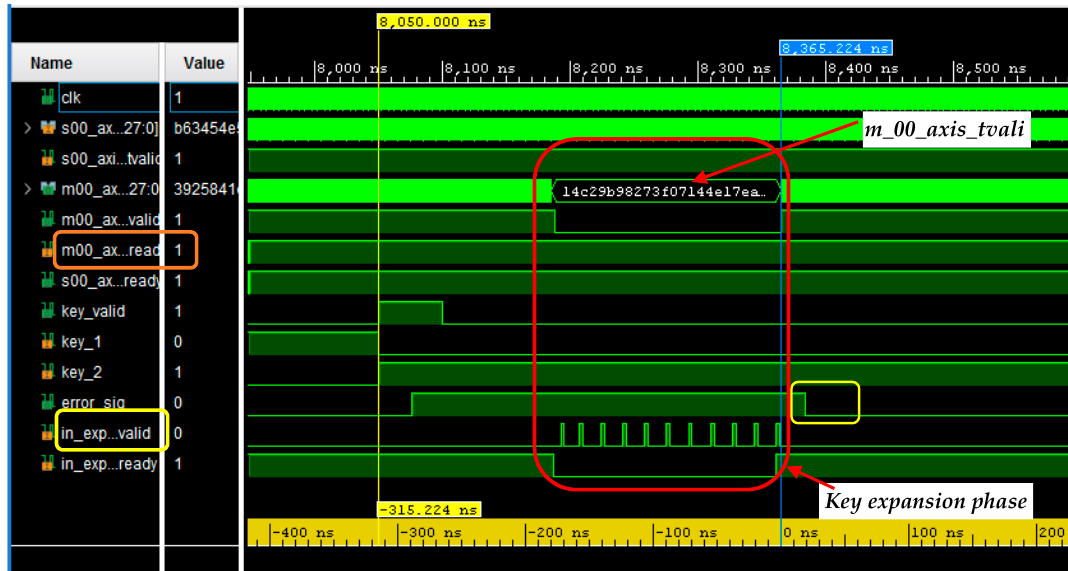
Figure 16. Temporal trends of the key expansion phase; the m00_axis_tvalid (orange box) signal indicates that during this phase there are no valid packets at the output of the encryption block; the signal that error_sig signal (yellow box) returns to zero as soon as the encrypted packets are obtained through the new key.